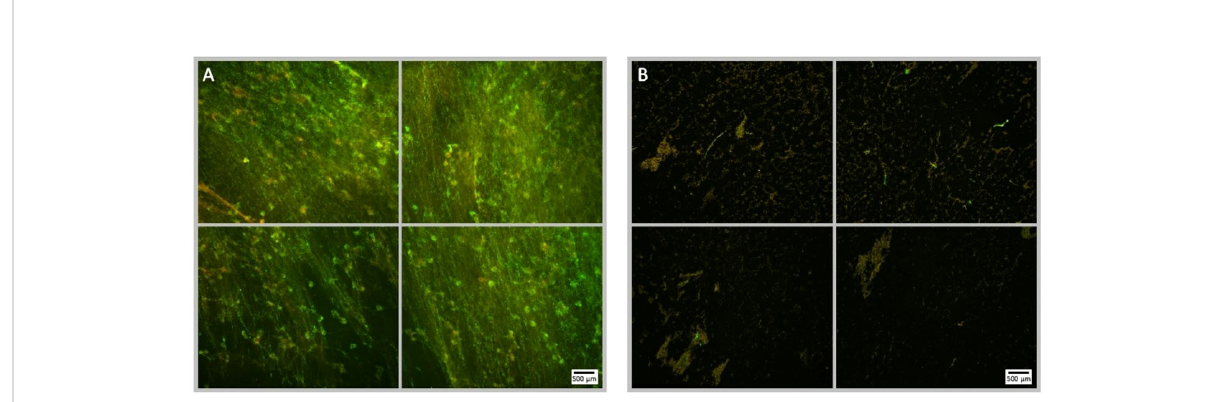
FIGURE 9 Fluorescence microscopy images of P. aeruginosa bio fi lm treated with NOMB + and sub-inhibitory gentamicin, stained with Syto9 (green) and PI (red). Panel (A) images depict the pre-treatment morphology of the bio fi lm over a 1 cm 2 area. Panel (B) images show the changes in morphology after ultrasound stimulation; 45 Vpp was applied to the transducer to reach an acoustic pressure of 0.5 MPa at the target site for 40 s, with a driving frequency of 0.9 MHz, duty cycle of 20% and a 500 Hz